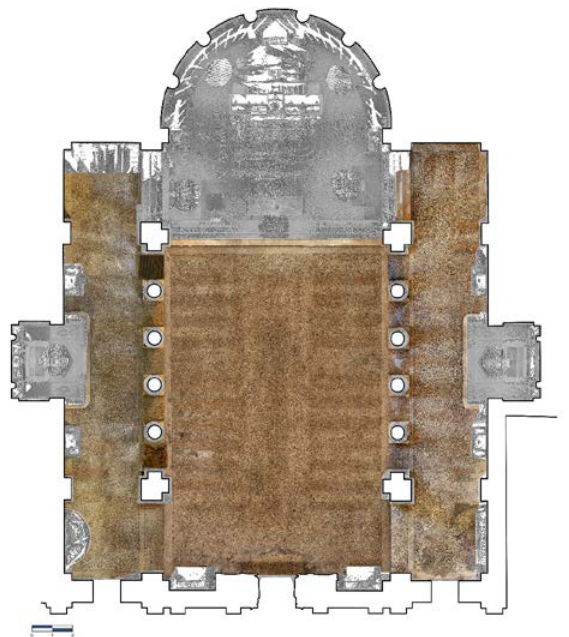
Figure 9. Internal plan with the photogrammetric floor texture